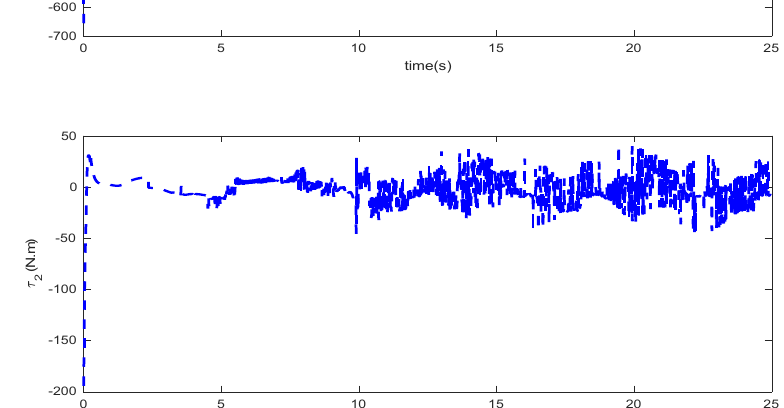
Figure 11. Control input in Scenario 2.